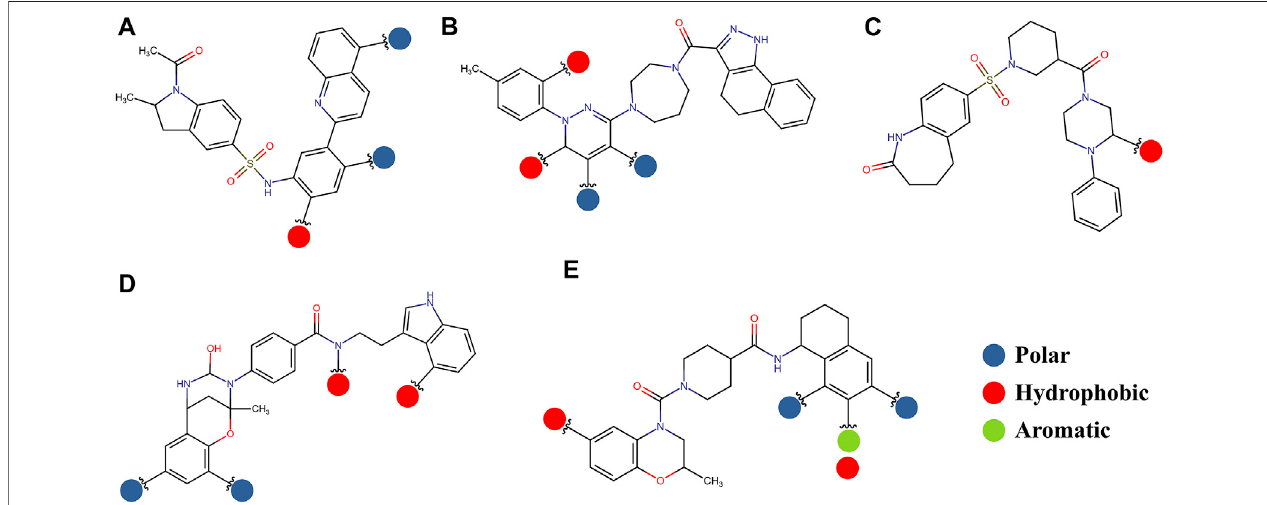
FIGURE 11 | Possible structural modi fi cations for the compound 1md bound to the GTP-binding site (A) , compound 8md bound to the region ofthe KDKE tetrad (B) , compound 9sd bound to the SAM-binding site (C) , compound 4md bound to the cavity B (D) , and compound 7sd bound to the region of the GDD motif (E) . The polar, hydrophobic, and aromatic patterns are shown as blue, red, and green spheres, respectively. These spheres show the position on each compound where they can be located.